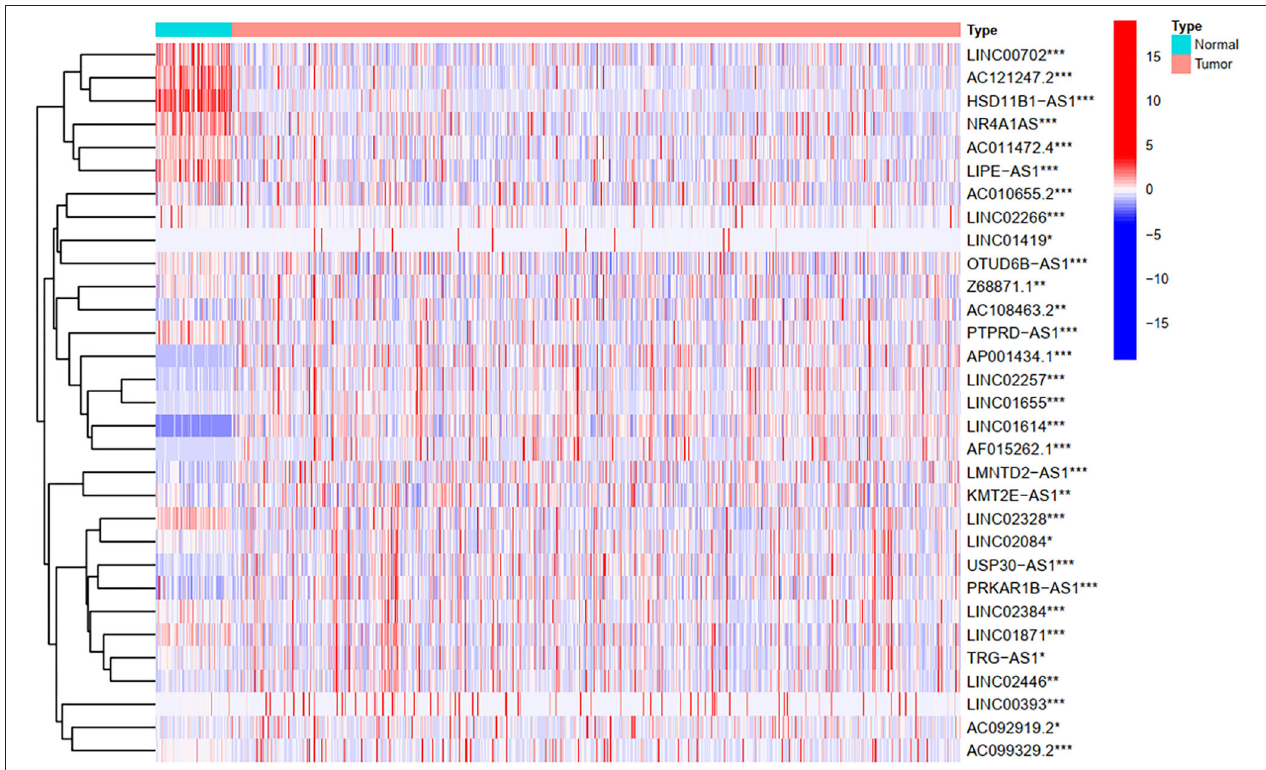
FIGURE 3 | The heatmap shows the differential expression of the prognostic between normal and tumor tissues. * P < 0.05, ** P < 0.01, *** P < 0.001.